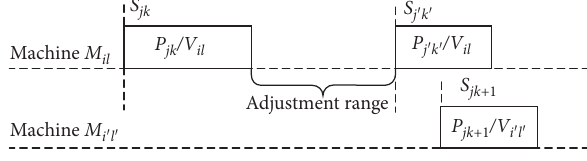
jk is not the last operation